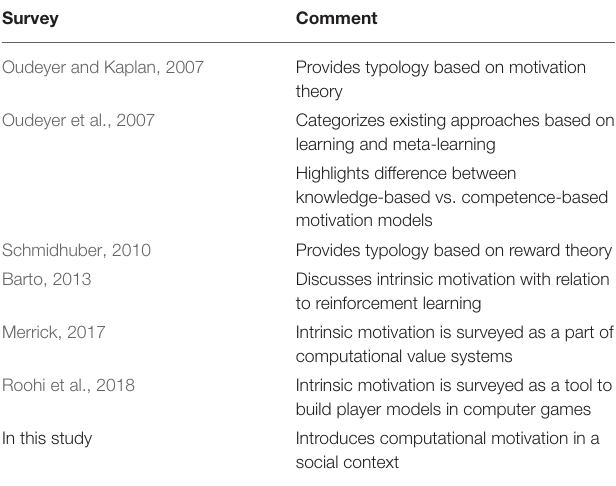
TABLE 1 | Summary of reviews on intrinsic motivation in artificial agents and contribution of our survey.